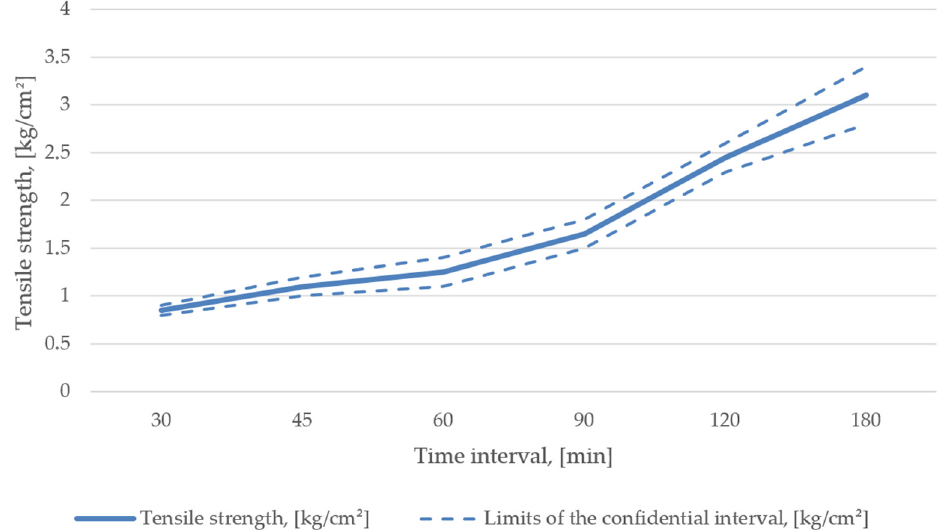
Figure 7. Mechanical properties of mixture recipe No. 3.